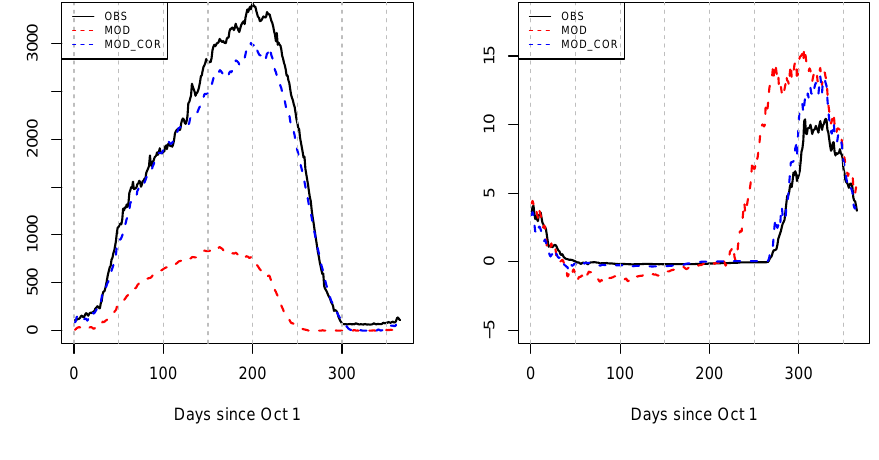
Figure 6. Evolution of SD and GST at a high-snowfall IMIS site (Val Bedretto); linkage between GST and SD is very clear. Correction of SD using the SBC method improves GST estimate.